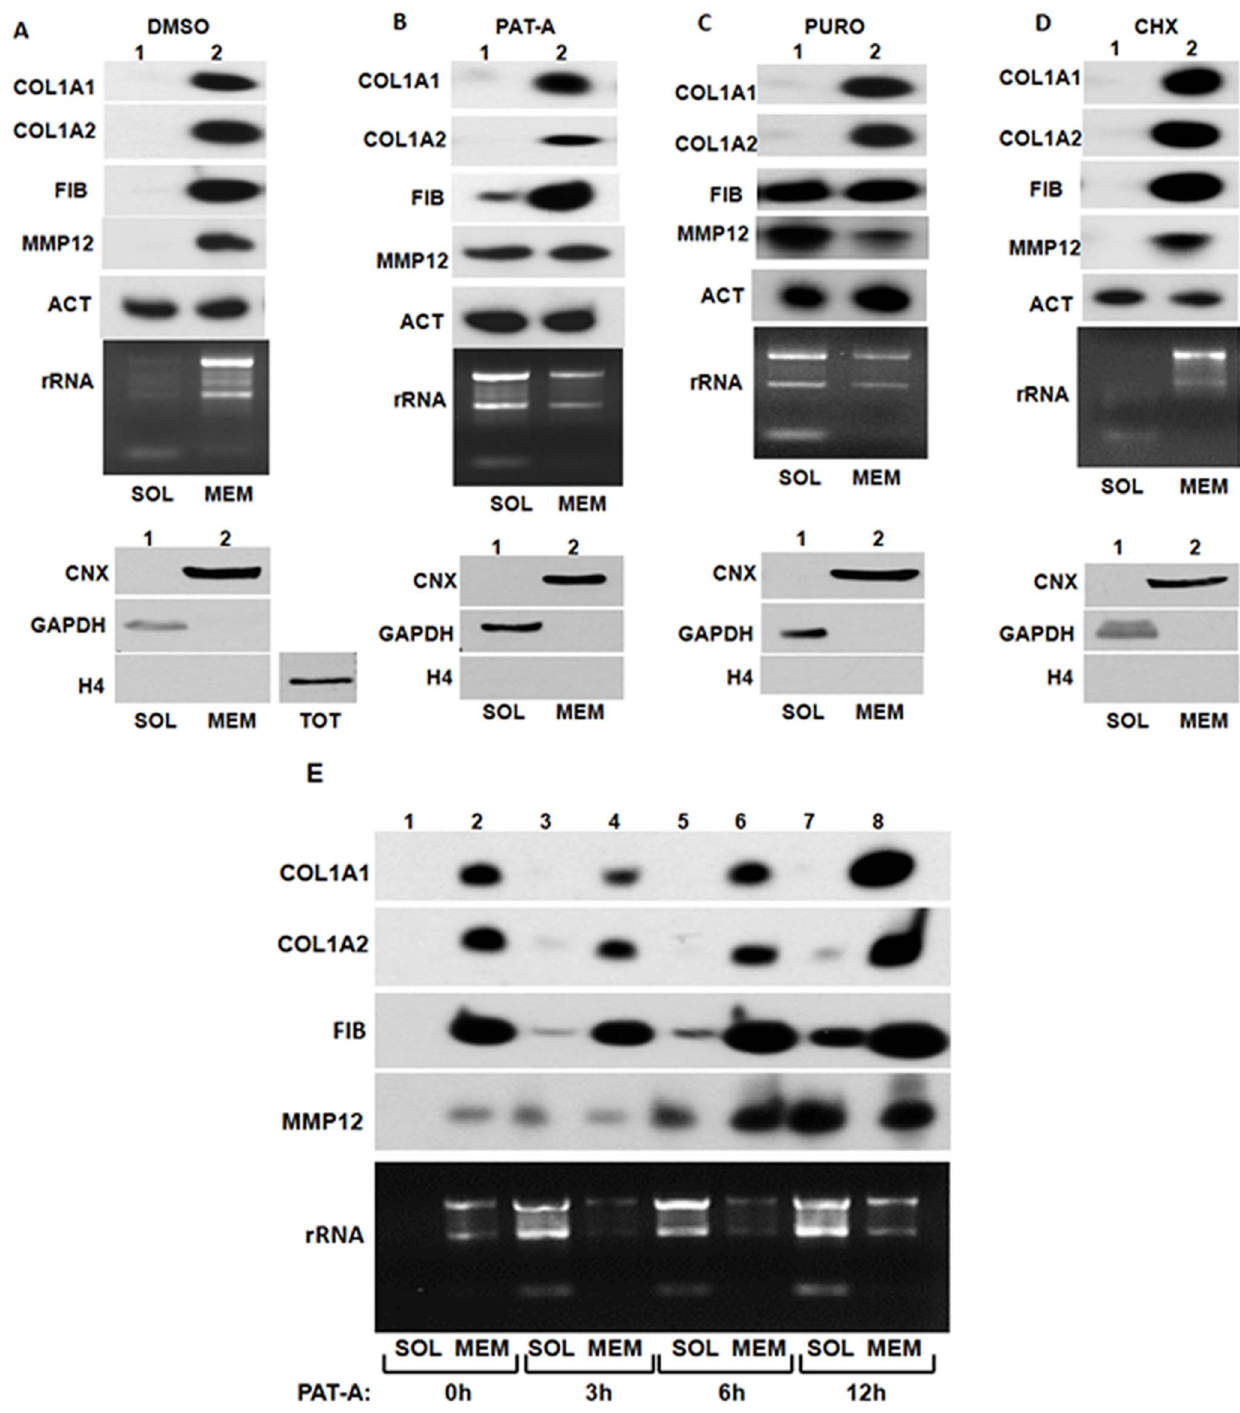
Figure 1. Translation is not required for membrane localization of collagen mRNAs. A. membrane partitioning of collagen mRNAs in control cells. Upper panel: HLFs were fractionated in cytosolic fraction (SOL, lane 1) or membrane fraction (MEM, lane 2) and collagen a 1(I) (COL1A1), collagen a 2(I) (COL1A2), fibronectin (FIB), matrix metalloproteinase 12 (MMP12) and actin (ACT) mRNAs were analyzed by RT-PCR. Distribution of ribosomal RNA (rRNA) is shown by agarose gel electrophoresis and ethidium bromide staining. Bottom panel: distribution of calnexin (CNX), GAPDH and histone H4 proteins in the fractions, analyzed by western blot. TOT; total cellular extract showing reactivity of the histone H4 antibody. B. Partitioning of collagen mRNAs after translation inhibition by pateamine A (PAT-A). Experiment as in A, except the cells were treated with PAT-A for 3 h prior to harvesting. C. Partitioning after translation inhibition by puromycin. D. Partitioning after translation inhibition by cycloheximide. E. Time course of mRNA redistribution after inhibition of translation. HLFs were treated with PAT-A for the indicated time periods and cells were fractionated into cytosolic (SOL) and membrane (MEM) fractions and the distribution of the mRNAs was analyzed by RT-PCR.